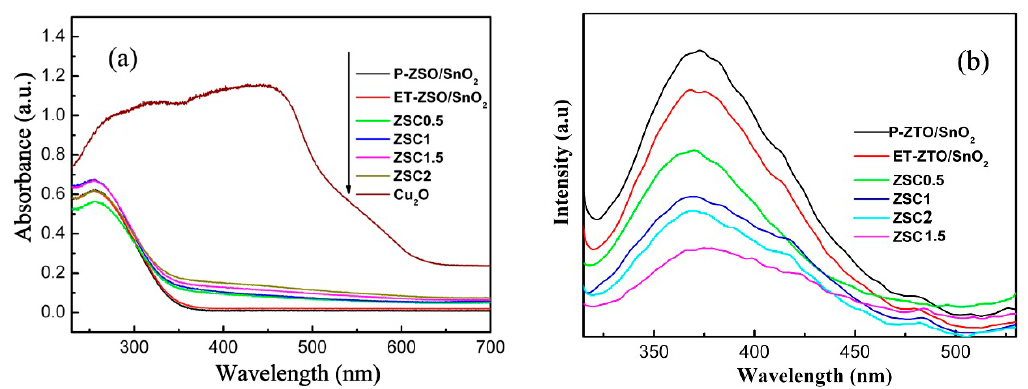
Figure 6. ( a ) UV–vis absorbance spectra of P-ZSO/SnO 2 , ET-ZSO/SnO 2 , and ZSC hybrids with different weight ratios, ( b ) PL spectra of P-ZSO/SnO 2 , ET-ZSO/SnO 2 , and ZSC hybrids with different weight ratios.